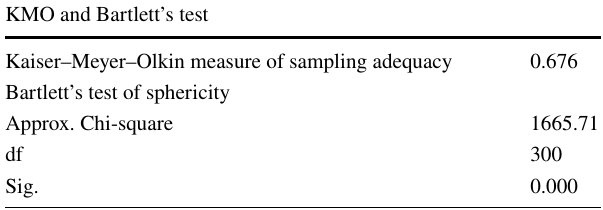
Table 2 Kaiser–Meyer–Olkin value (0.676) of summer season data,